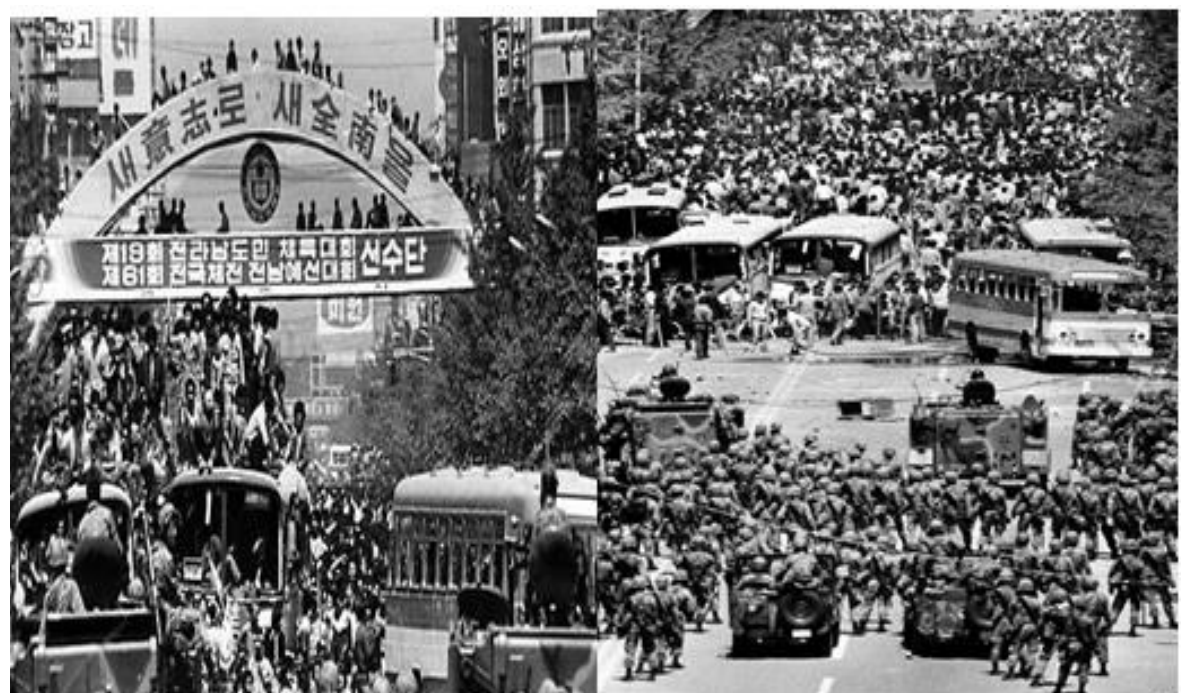
Figure 2. Gwangju Democratic Uprising 18 May 1980–27 May 1980, Data source: 18 May, Democratic Uprising Archives, https://www.518archives.go.kr/, (accessed on 22 January 2021).